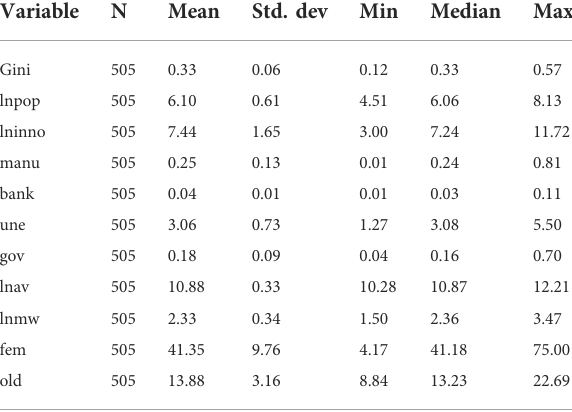
TABLE 2 Descriptive statistics (annual